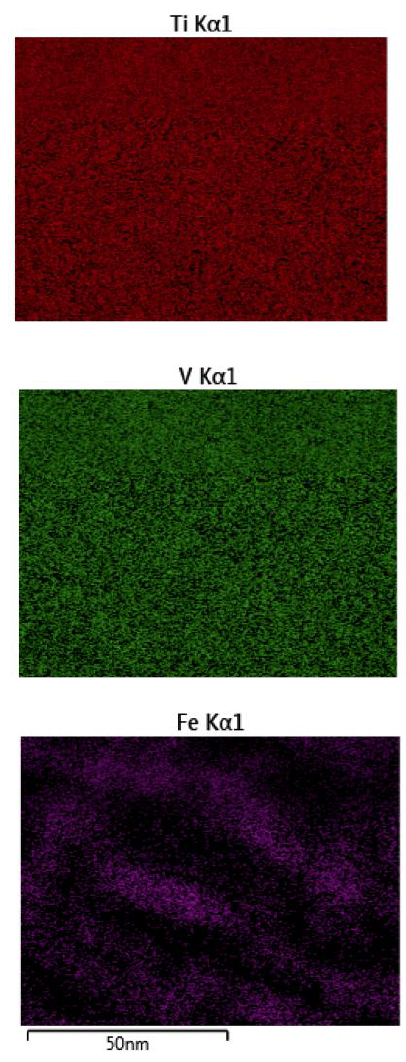
Figure 11. Typical energy dispersive X-ray spectroscopy (EDS) signals from Ti, V and Fe in Ti 0.63 V 0.27 Fe 0.10 D 1.73 .